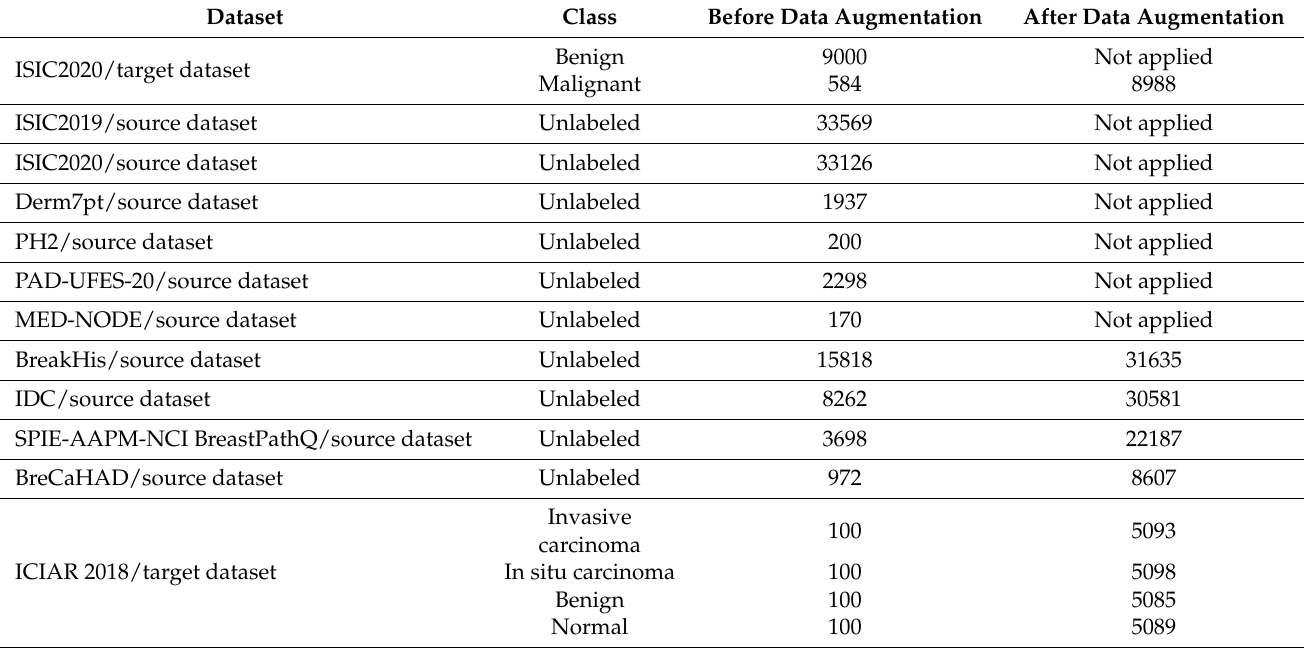
Table 3. Data augmentation to increase the samples of the datasets after the data preparation